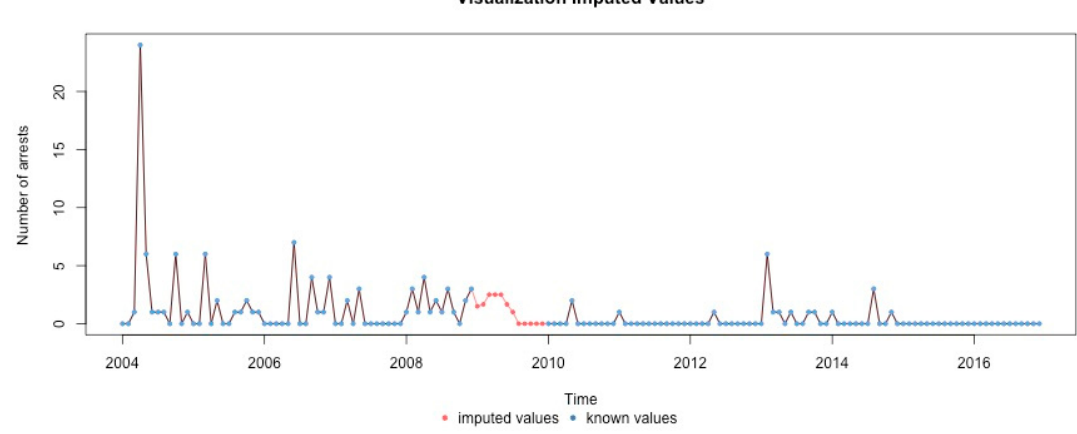
FigureA23. Heroinorganizedforeignnationalscrimearrests2004–2016intheCzechRepublic—imputed Figure A23. Heroin organized foreign nationals crime arrests 2004–2016 in the Czech Republic – missing imputed missing values.